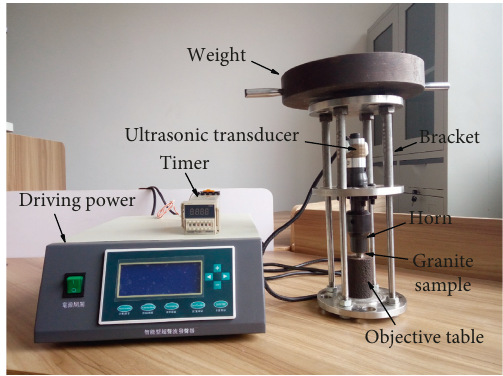
Figure 4: Ultrasonic high-frequency excitation experimental device.